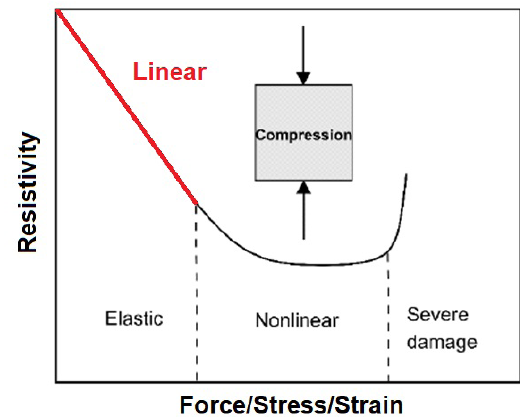
Figure 3. Graphic relationship between electrical resistivity and mechanical effort in a self-sensing composite (adapted from 25